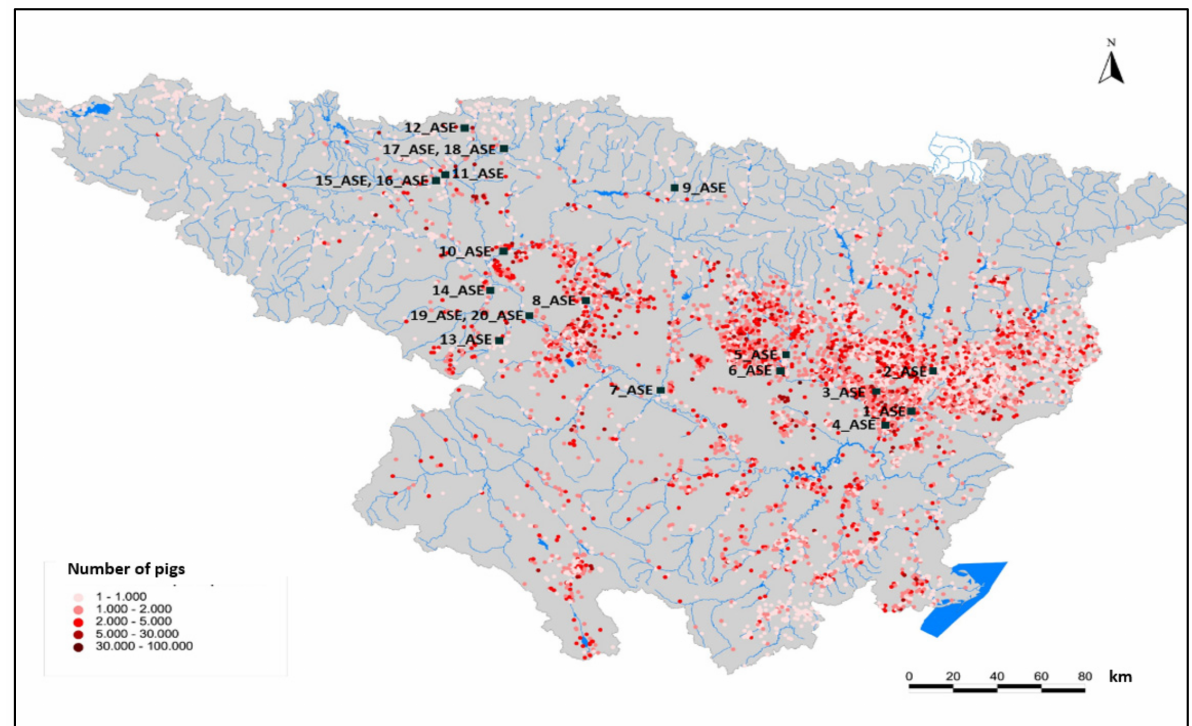
Figure 2. Distribution of number of pigs per farm in the Ebro River basin and sampling points (Source: Ebro Hydrographic Confederation, 2016).